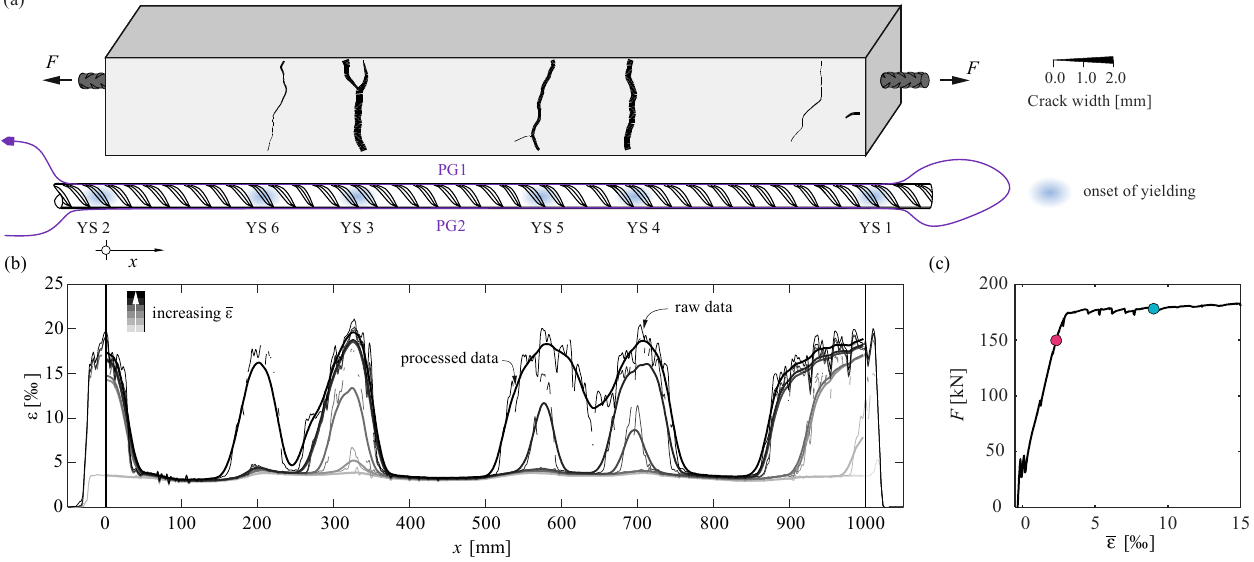
Figure 9. RC tie subjected to uniaxial loading (specimen ERV): ( a ) schematic representation of the tested specimen with the crack patterns and crack widths at F = 175 kN (top) measured with DIC, and location of the yield sections (YS) along the bar (bottom); ( b ) DFOS strain distribution along the specimen and ( c ) load–deformation curve.